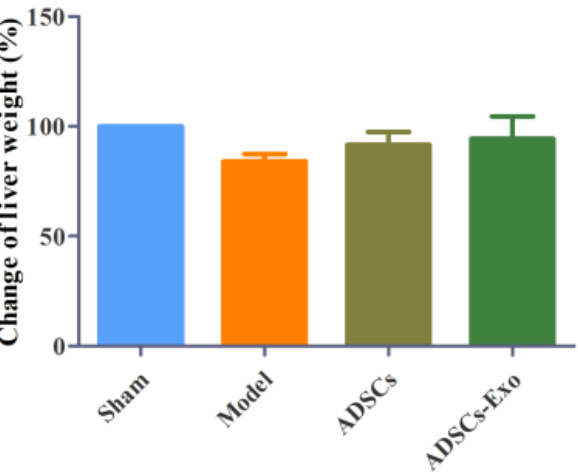
Figure 7. Effects of ADSCs-Exo and ADSCs on liver weight after ischemia and reperfusion combined with hepatectomy injury.